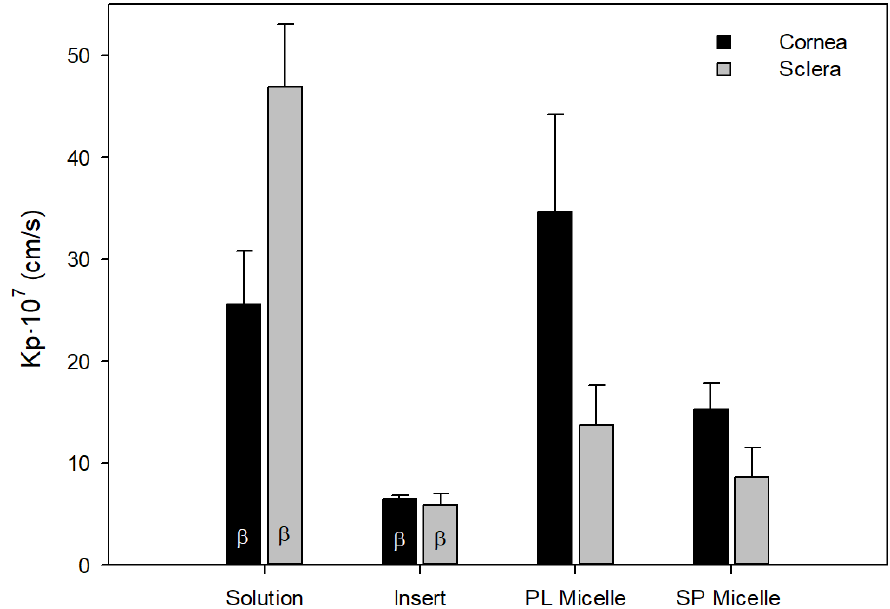
Figure 5. Apparent permeation coefficients (P eff , cm/s) of PG in the corneas and scleras of rabbits were obtained with different PG topical formulations. β indicates that those formulations were prepared as CD-PG (solution and inserts), whereas micelles of Soluplus and Pluronic were prepared with pure PG.